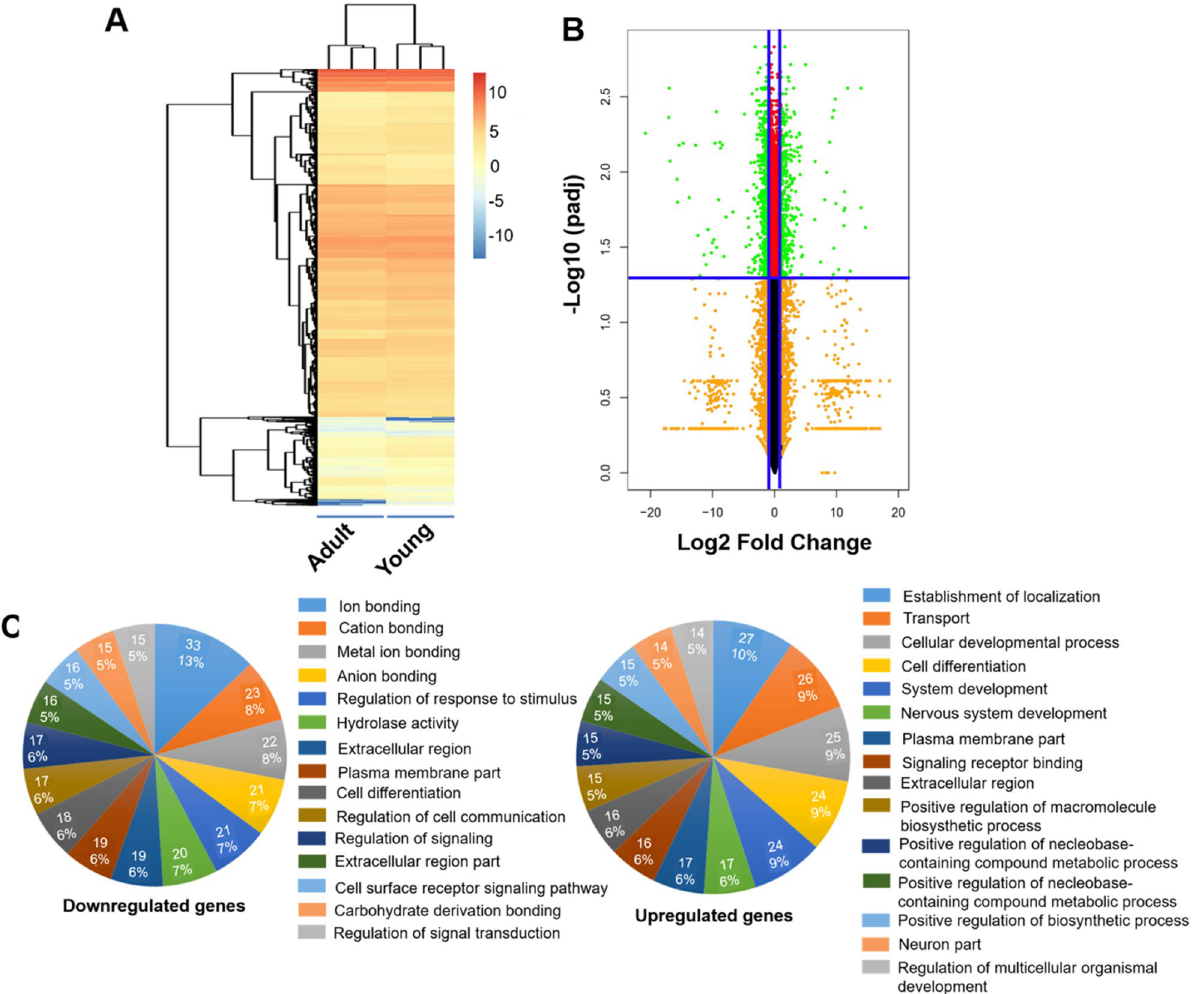
Figure 6. RNA sequencing reveals global gene expression alterations for P0 PVICs from young and adult PV leaflets. ( A ) Overall heatmap; ( B ) Volcano plot (Adult vs. Young); ( C ) Pie chart representation of GO analysis (Adult vs.